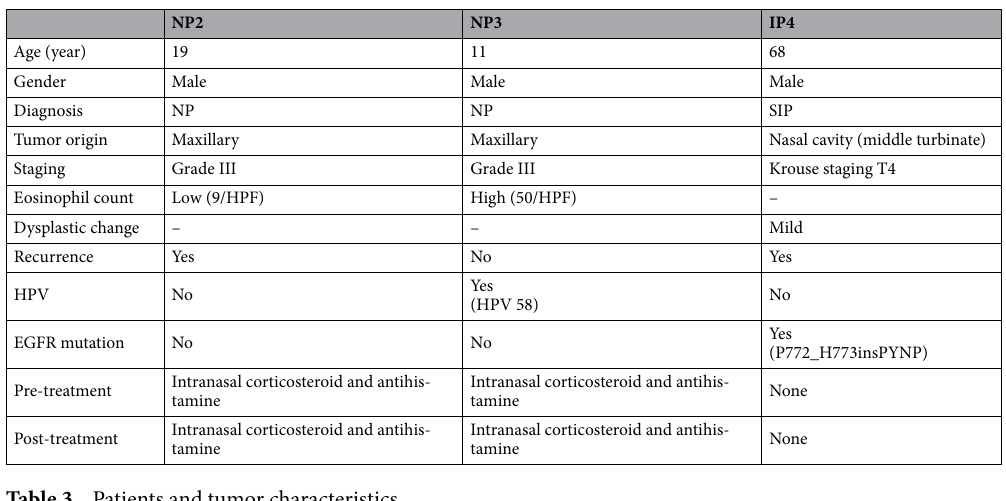
Table 3. Patients and tumor